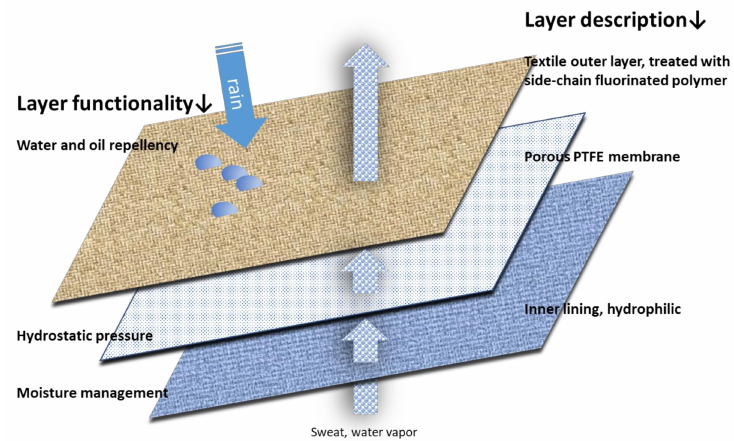
Figure 1. Scheme of a typical multi-layered fabric for outdoor